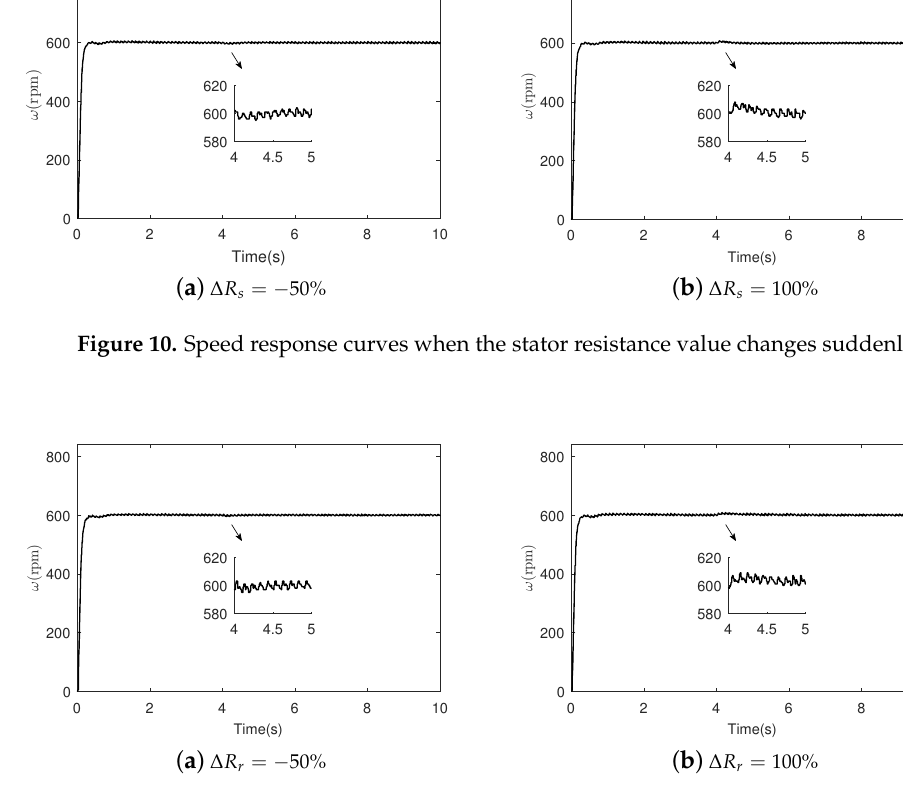
Figure 11. Speed response curves when the rotor resistance value changes